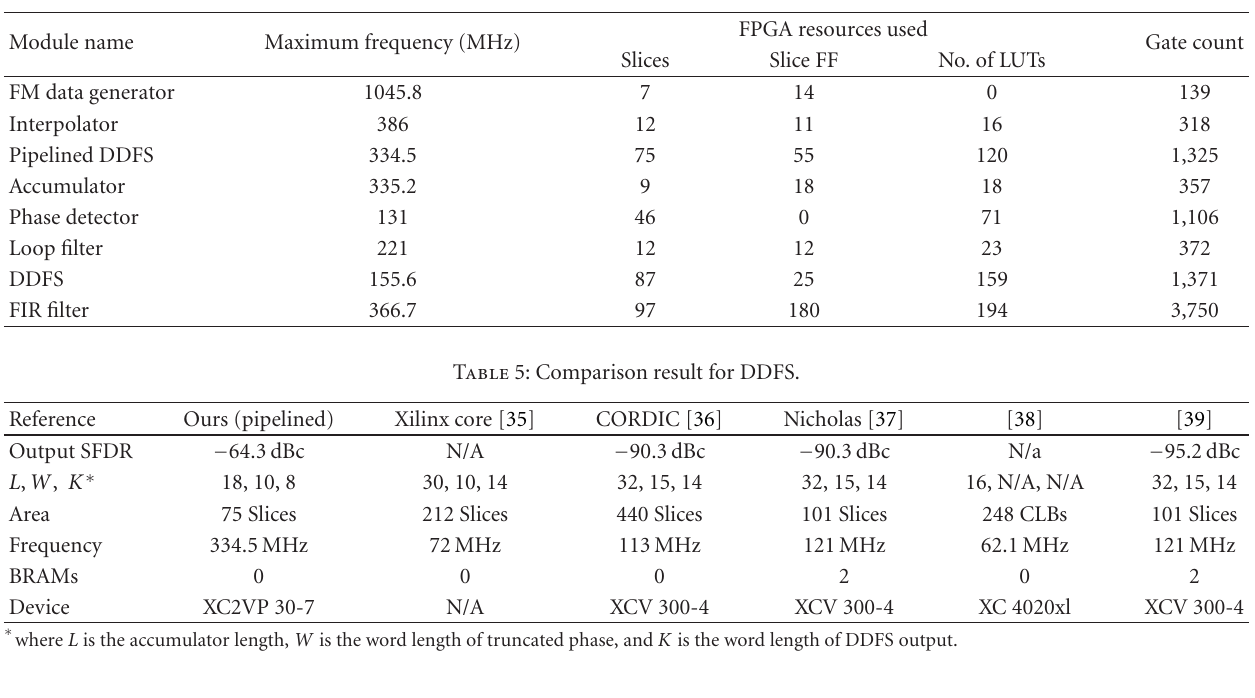
Table 4: Component wise FPGA implementation result.